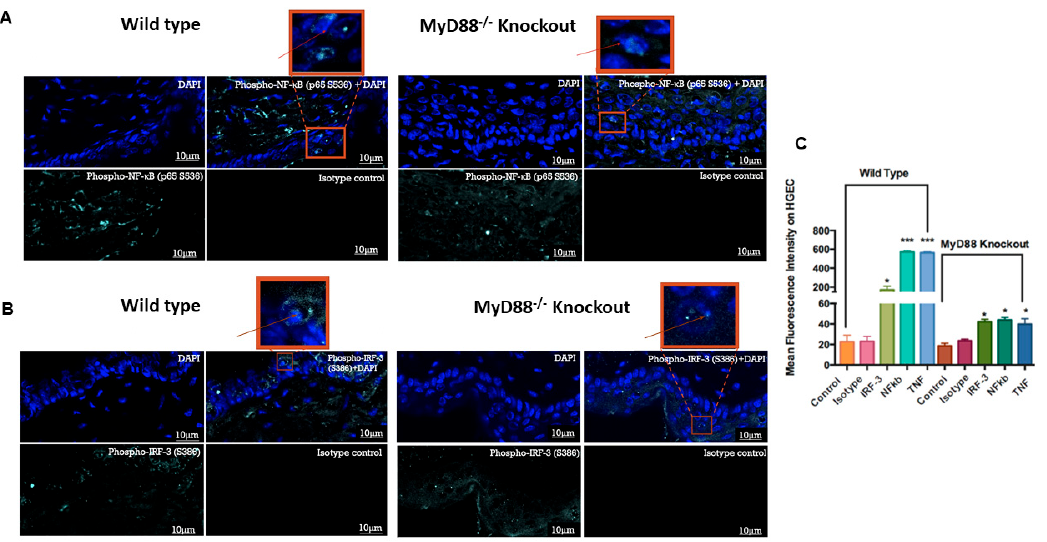
Figure 10. MyD88 knockout mice display downmodulated transcriptional factors to poly I:C stimulation: the skin of wild-type mice and MyD88 knockout mice challenged with poly I:C and immunofluorescence performed using phospho-NF-kB p65 (S536) antibody in skin tissue sections. A higher mean of fluorescence intensity was observed on the surface skin of the wild-type mouse (green (phospho-NF-kB p65); blue (DAPI)) ( A ). Furthermore, the skin tissue was stained for phospho-IRF3 (S386). A higher mean of fluorescence intensity was observed on the surface skin of the wild-type mouse (green (phospho-IRF3); blue (DAPI)) ( B ). (N = 8 mice per group in total (two independent experiments with n = 4 animals/group). Bar = 10 µm)). The intensity of immunofluorescence within the epidermis was quantified using ImageJ software. The mean fluorescence intensity was higher in the stained cells of the wild-type mouse compared to the values for the MyD88 − / − knockout mice ( C ). Statistical test: we performed one-way ANOVA, followed by Tukey’s multiple comparison test (* p < 0.05). The results represent the mean ± SE values from 8 animals per group in total (two independent experiments with n = 4 animals/group).